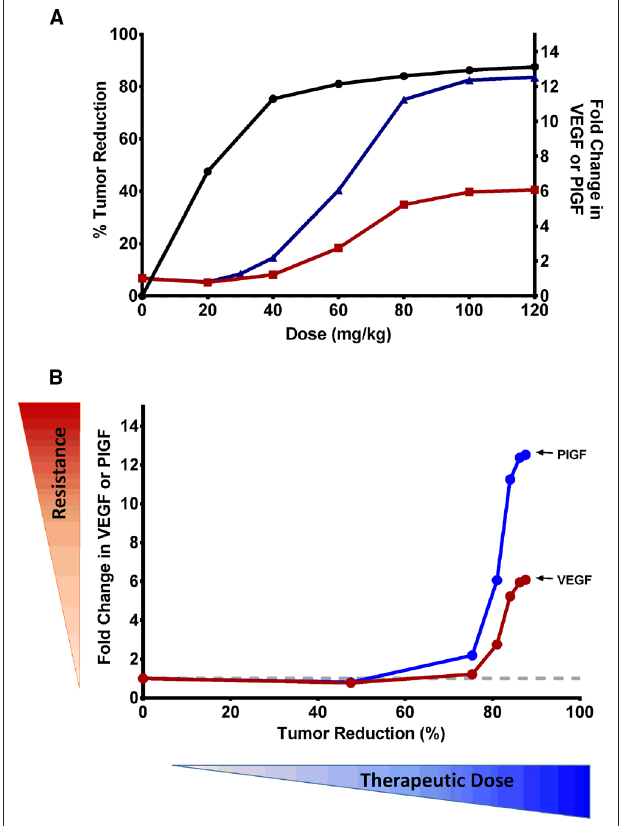
FIGURE 2 | (A) Relationships of therapeutic efficacy and modulation of VEGF and PlGF biomarkers to sunitinib doses. Percentage reduction in tumor volume ( • ) and fold change in PlGF ( (cid:78) ) and VEGF ( (cid:4) ) are shown at various doses of sunitinib at the end of study. At the dose of 40 mg/kg/day, ∼ 75% of tumor volume was reduced, with minimal upregulation of hypoxia-dependent CAF. Further dose escalation resulted in marginal therapeutic gain ( < 5%), but significant upregulation of CAF, which may indicate excessive anti-vascular effects. (B) Utilization of CAF biomarkers in the selection of biological dose of antiangiogenic drugs. The fold change in VEGF and PlGF may serve as a surrogate marker for excessive anti-vascular effects and, in turn, potential for emerging resistance. This illustrates how the biologically effective dose may be selected in a manner which does not invoke significant hypoxia and involves little stimulation of hypoxia-dependent CAF. Monitoring multiple CAFs will be advantageous, as each factor has a different dynamic range. PlGF has a wider dynamic range than VEGF, and results in higher fold change at the same dose. This provides an advantage over VEGF, because PlGF changes are more likely detectable even at lower